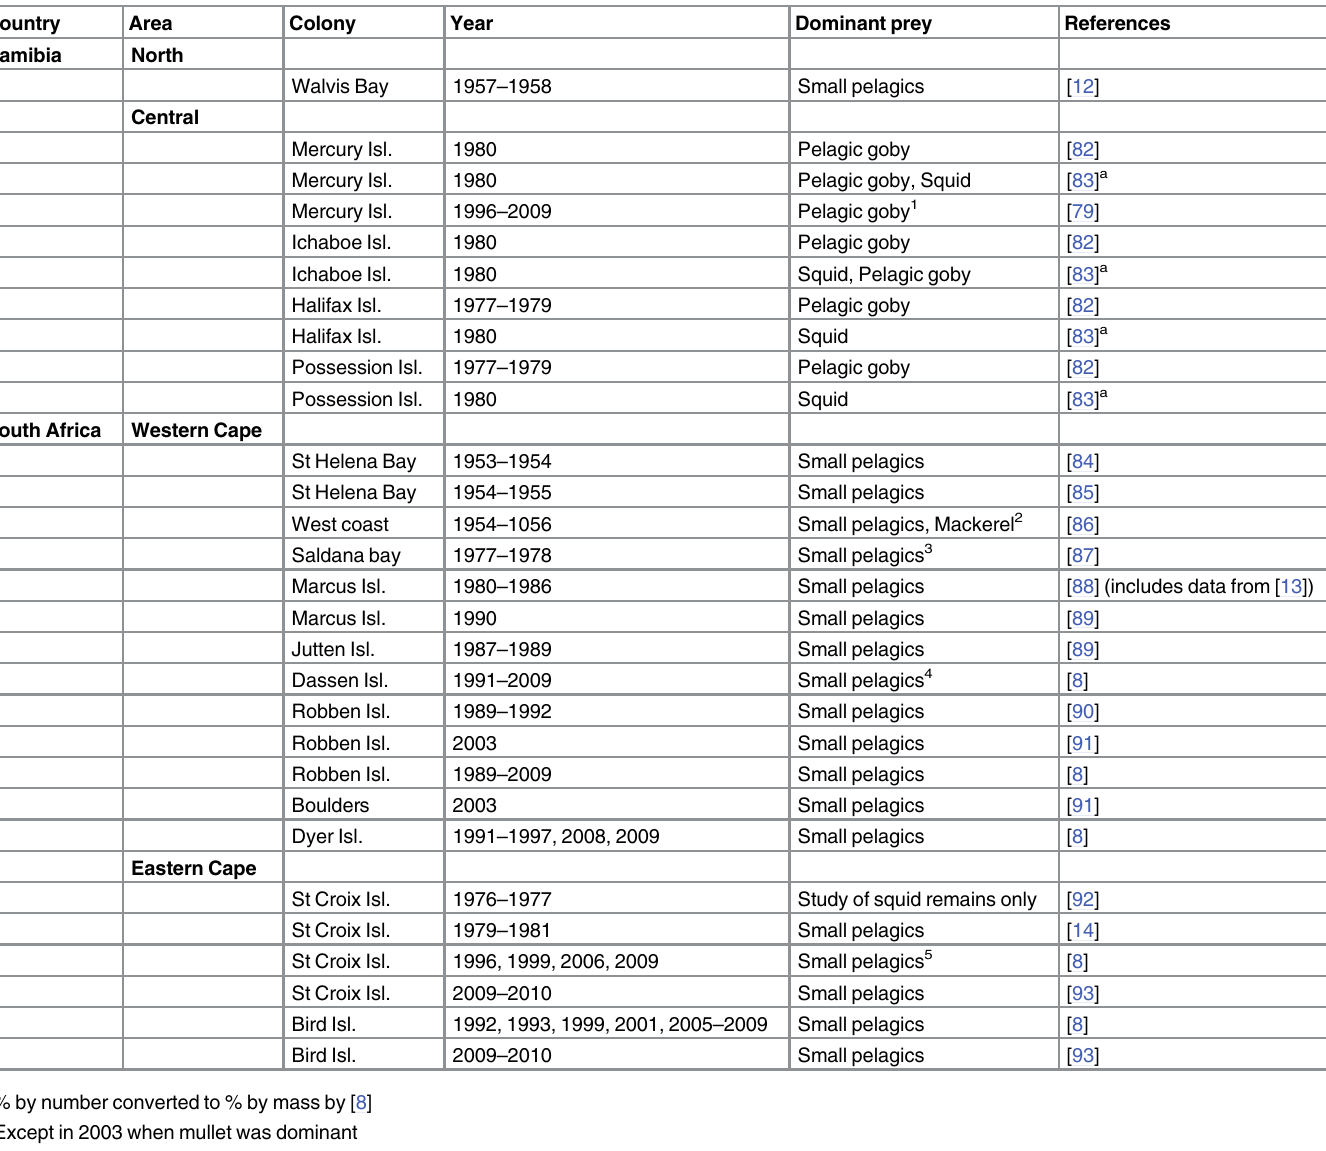
Table 4. Studies that focused on the African penguin diet along its breeding range. Colonies are listed from West to East along the southern African coast. Small pelagics consists out of anchovy and sardine.